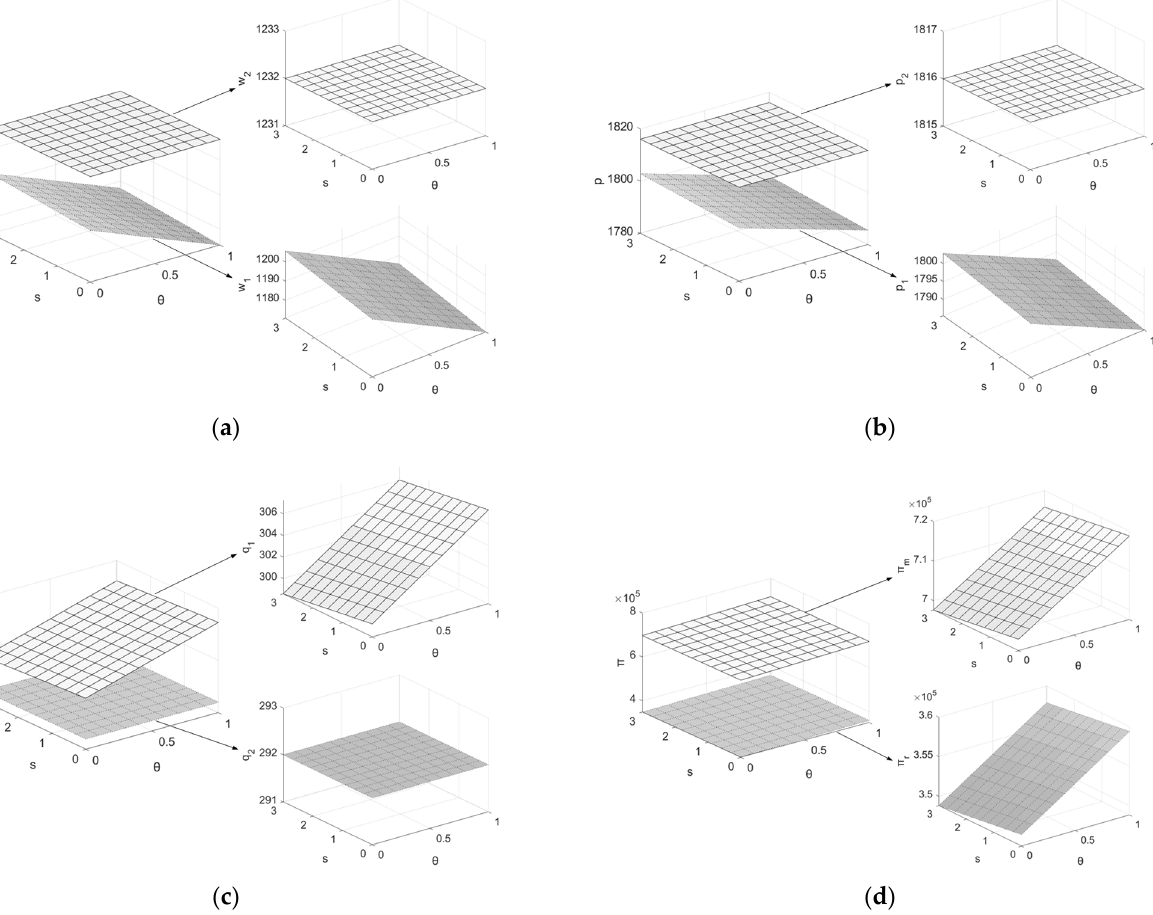
, w w s θ and on 1 2 ; ( b ) effects of s θ and on